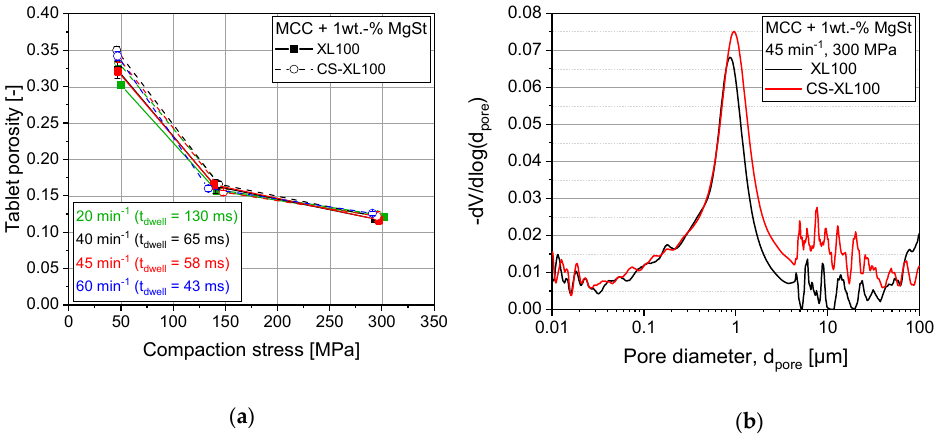
Figure 7. Effect of compaction simulation on porosity ( a , n = 10) and pore size distribution ( b , n = 1) of MCC + 1 wt.-% MgSt tablets.